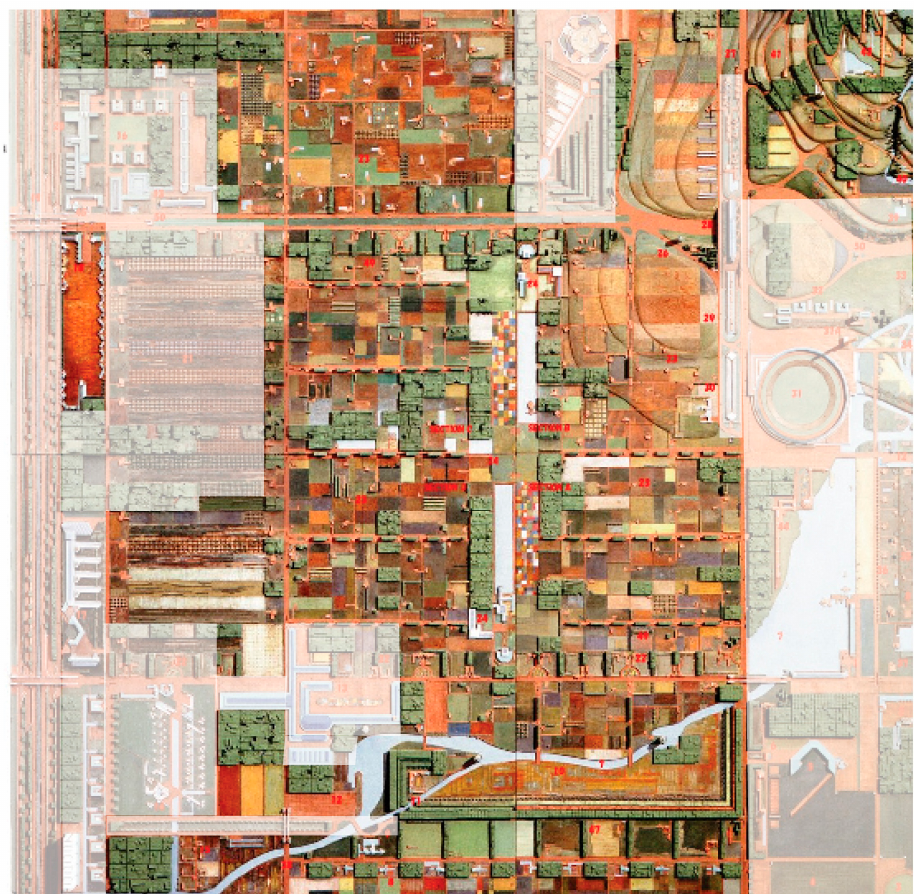
Figure 2. Cultivated spaces within Frank Lloyd Wright’s Broadacre City (non-agricultural areas blocked in white). Diagram by authors based on photo of model, Museum of Modern Art, New York City.